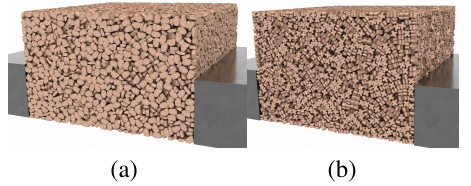
Figure 5. Initial packed state at 50 kPa for (a) HexP and (b) Cross shapes.